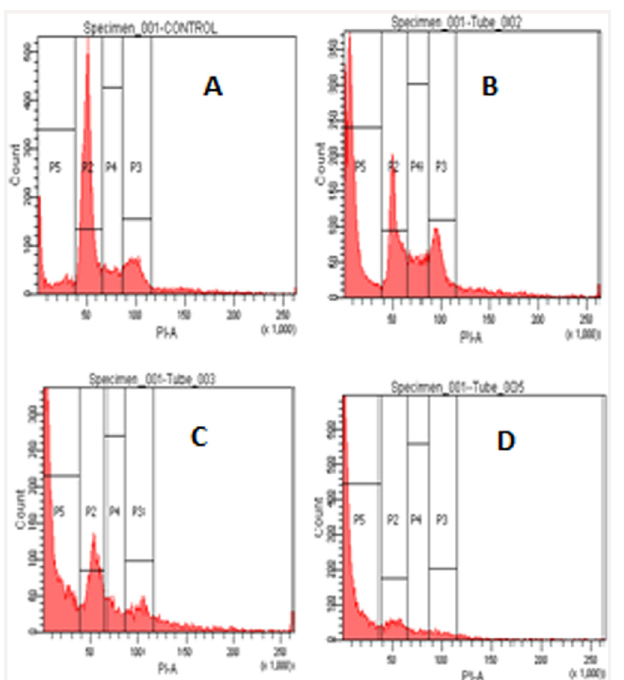
Fig 14. Cell cycle distribution of HeLa cells treated with different concentrations of ‘ fungal VCR ’ . The sub-G0/G1, G1, S and G2/M phases are represented on the histogram as P5, P2, P4 and P3, respectively. A — control, B — fungal VCR (5 μ g/ml), C — fungal VCR (10 μ g/ml), D — fungal VCR (25 μ g/ml) and E — percent